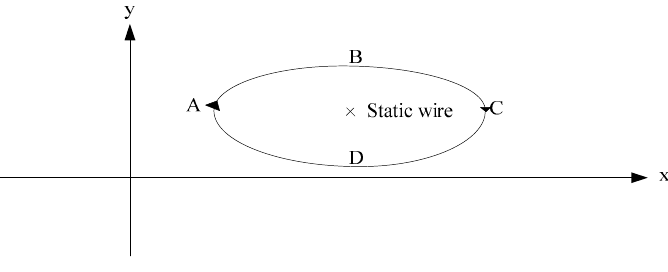
Figure 4. Elliptical trajectory of monitoring nodes.